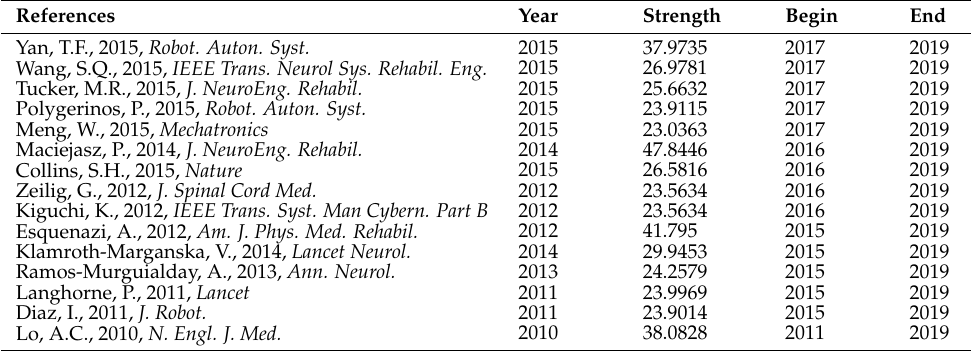
Table 8. Top 15 citation bursts until